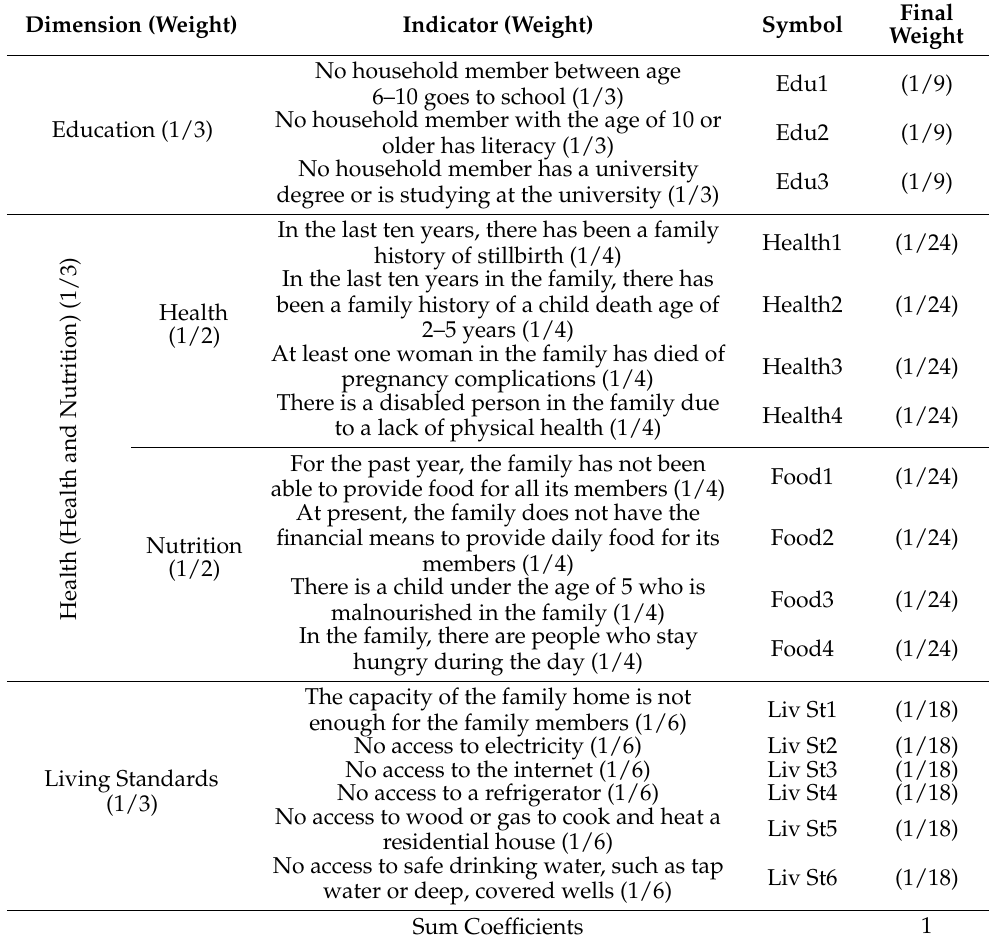
Table 1. Deprivation indicators of households and their